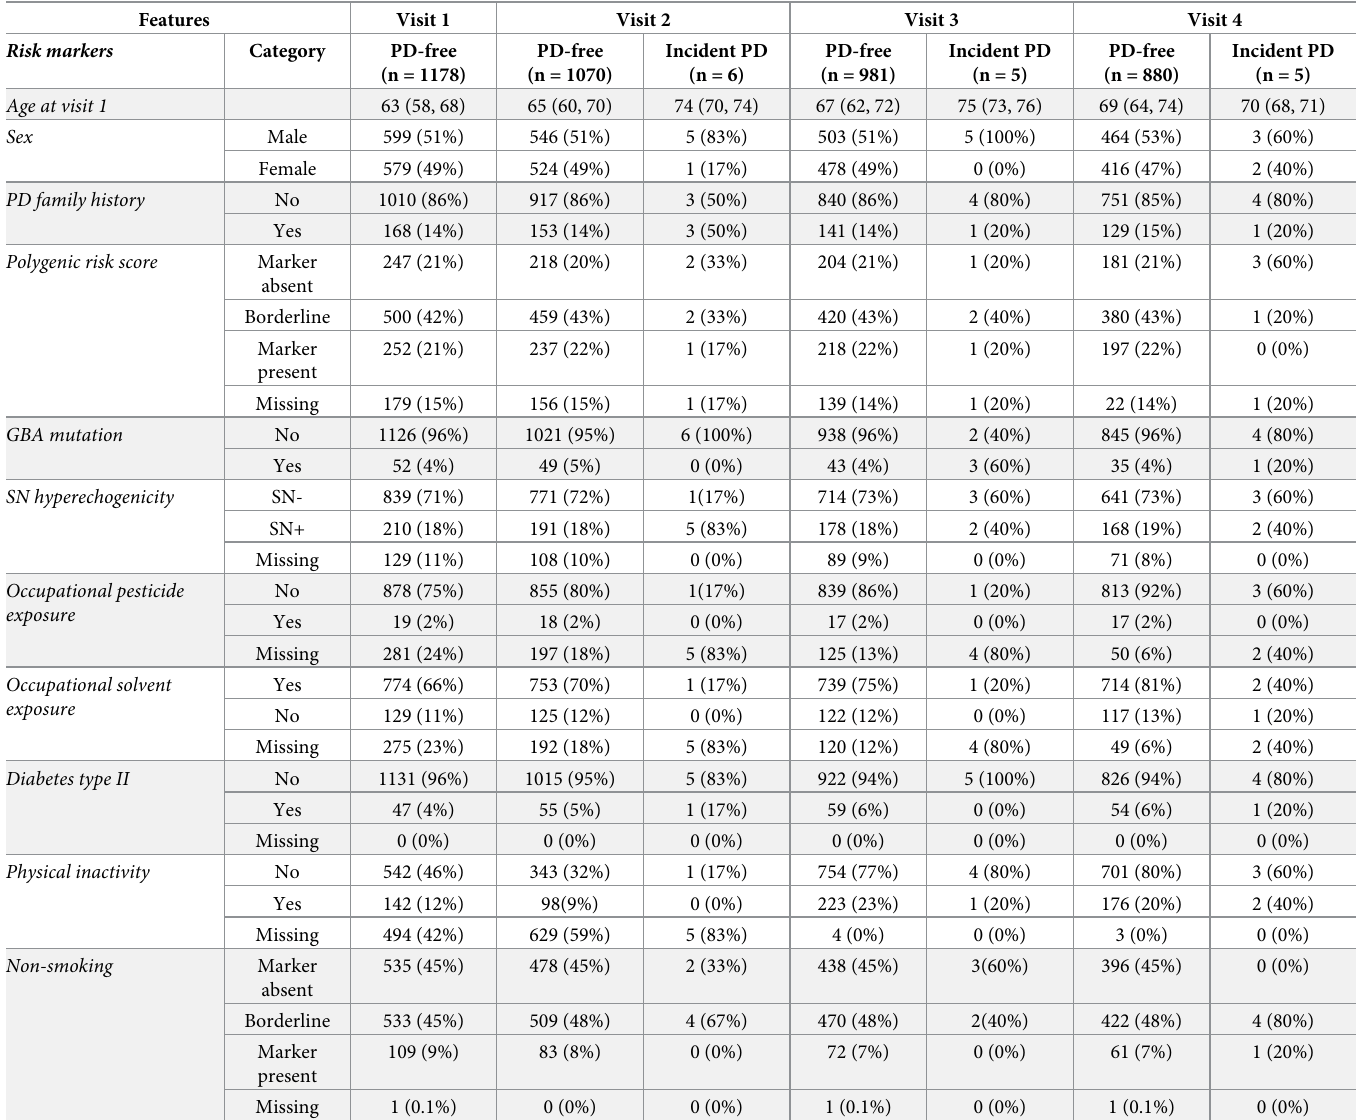
Table 1. Age and risk markers of PD in the prospective TREND